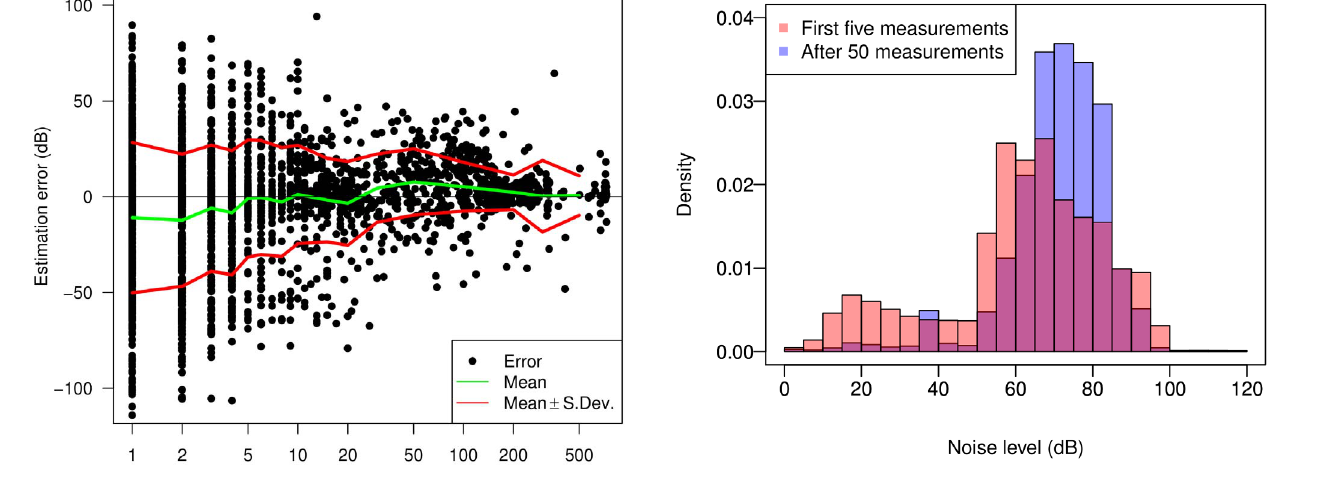
Figure 13. Distribution of measured noise levels. The plot shows the histogram of noise levels for the first measurements performed by users, compared to those performed after some experience is gained (after the 50th